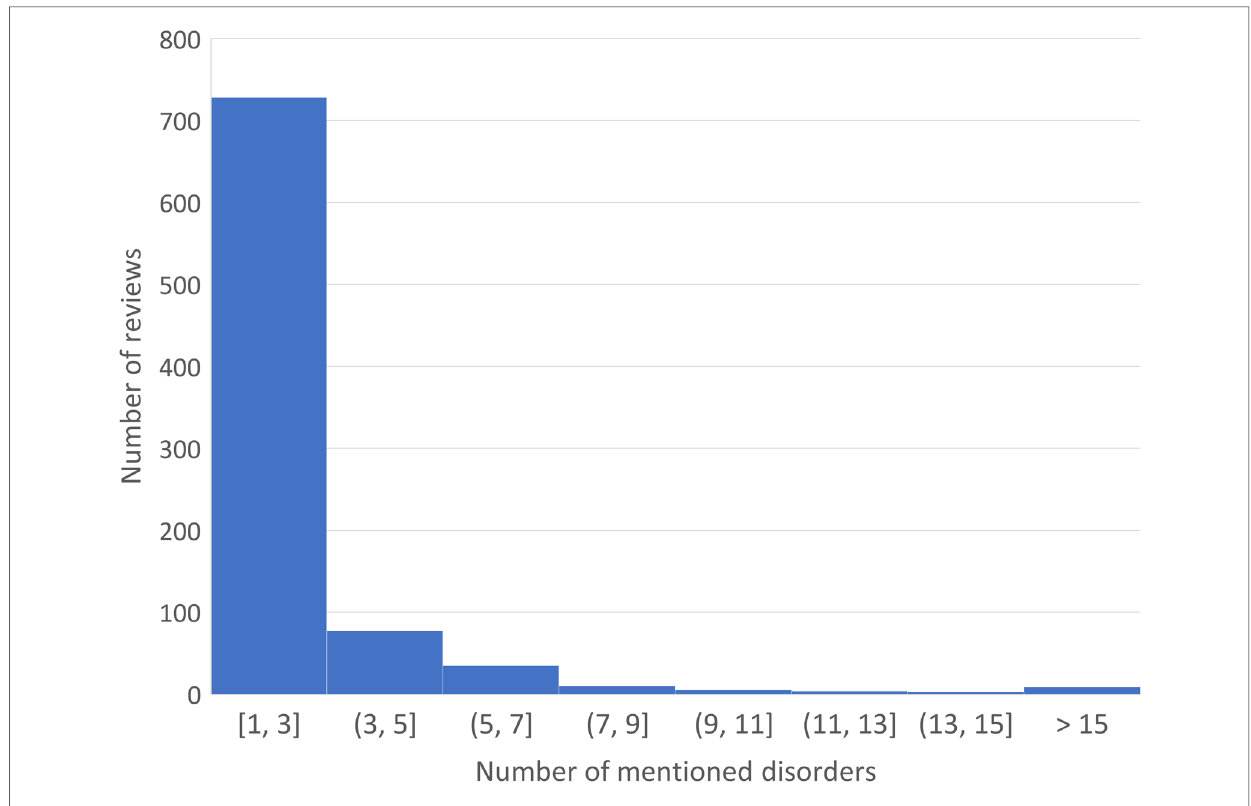
FIGURE 4 Distribution of the disorder terms mentioned per